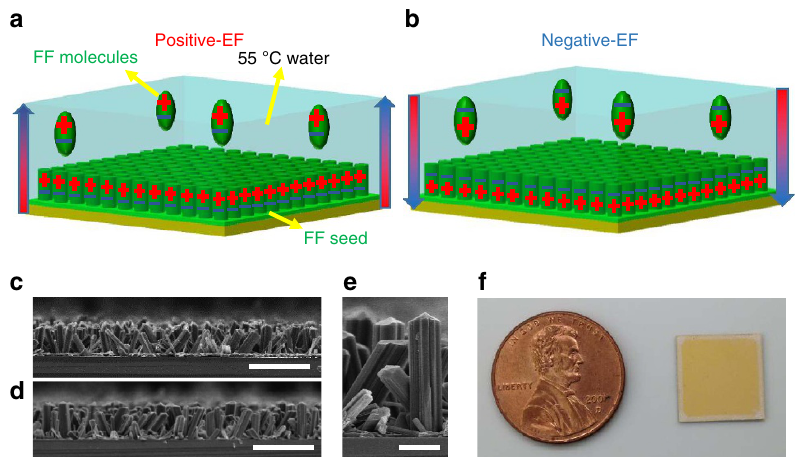
Figure 1 | Growth of vertical FF peptide microrod arrays with controlled polarization. ( a , b ) Schematic of the positive-EF (electric field) growth ( a ) and the negative-EF growth ( b ). The large arrows are the directions of the applied electric fields, and the plus and minus signs indicate the polarizations of the FF molecules and FF microrods. ( c , d ) Cross-section views of arrays from the positive-EF growth ( c ) and the negative-EF growth ( d ). Scale bars in ( c ) and ( d ) are 100 m m. ( e ) High-magnification view of vertical microrods. Scale bar, 20 m m. ( f ) Photography of vertical FF peptide microrod array grown on a gold-coated substrate. The yellow gold layer is visible owing to the vertical alignment of microrod arrays and good optical waveguide properties along their axial directions.